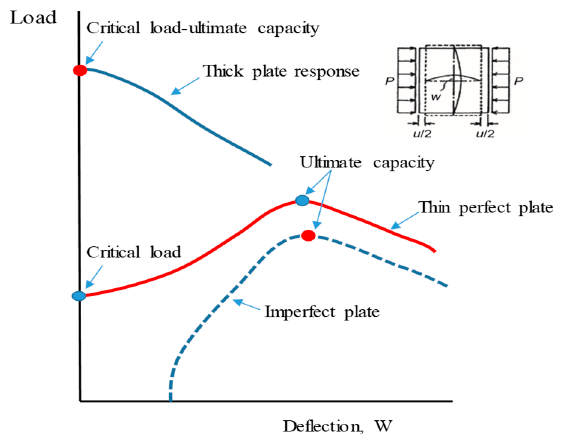
Figure 1. Fundamental behavior of plates under uniaxial compressive load.